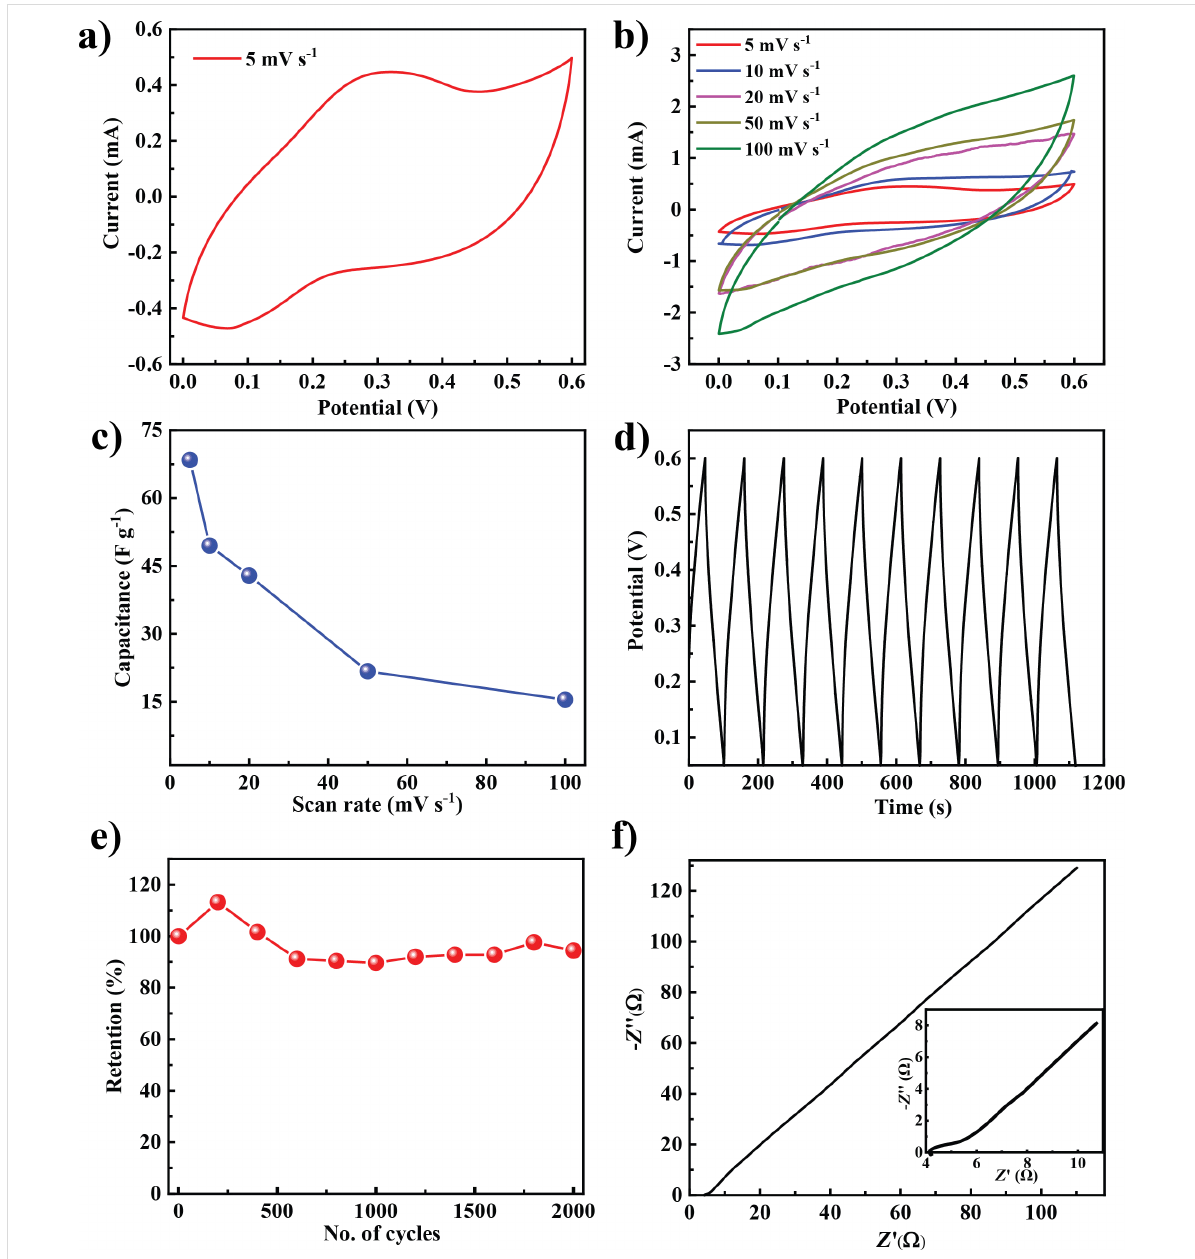
Figure 4: Supercapacitor characterization of a MoO 3 /5 wt % CB composite in two-electrode configuration. (a) CV curve of the symmetric capacitor at a scan rate 5 mV·s − 1 ; (b) CV curve at different scan rates; (c) capacitance as a function of the scan rate; (d) galvanostatic charge–discharge; (e) cyclic stability and (f) electrochemical impedance spectrum with enlarged view in the inset.